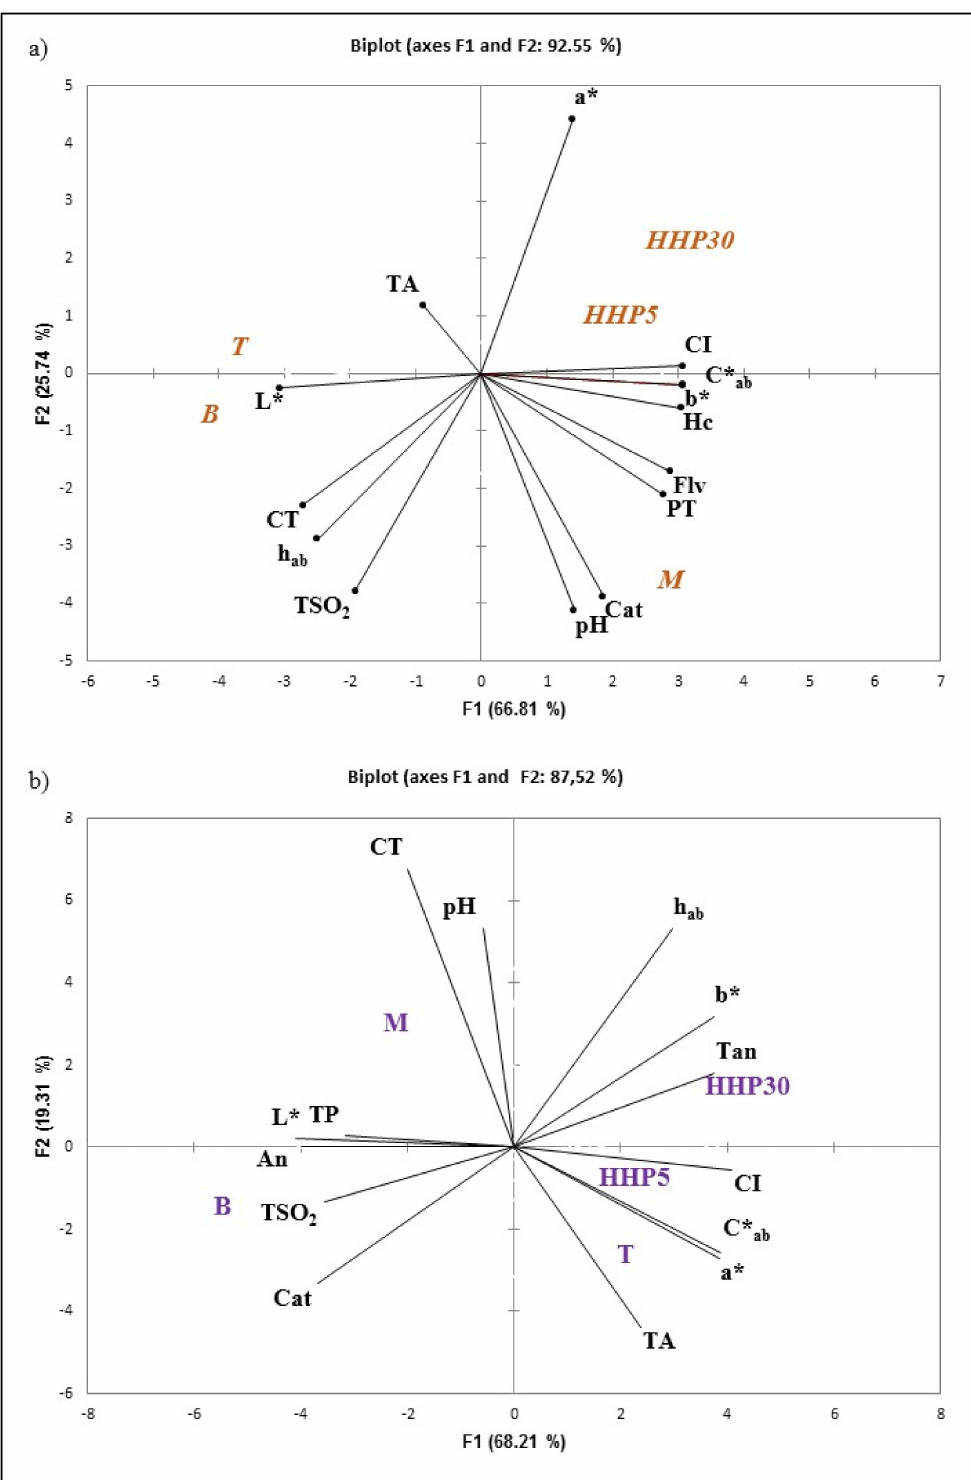
Figure 6. Principal component analysis of Cayetana ( a ) and Tempranillo ( b ) wine treated and untreated by HHP and holm chips. B: Wines bottled without any treatment; HHP5, HHP30: Wines bottled after maceration of holm oak chips (5 g/L) with HHP treatments (400 MPa, 5 and 30 min). M and T: Wines bottled after storage for 45 days in tanks with and without maceration of holm oak chips (5 g/L). TA: Total acidity; VA: Volatile acidity, TSO 2 : Total SO 2 , Hc: Hidroxycinamic compounds, Flv: Flavonoids compounds, TP: Total polyphenols; Cat: Catechins; An: Anthocyanins; Tan: Tannins; CI: Color intensity; CT: Tint; L*, a*, b: CIELAB Coordinates; C* ab Chromaticity; h ab : Hue